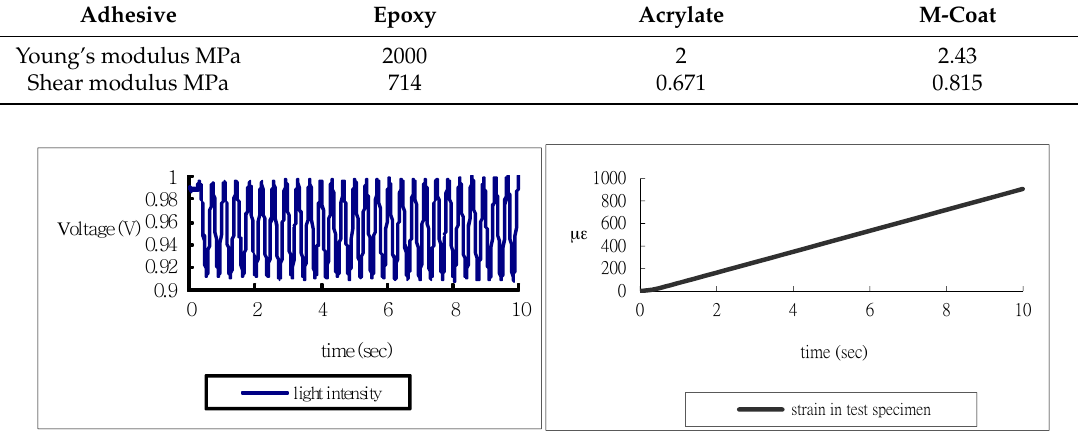
Figure 4. Light intensity of Mach-Zehnder interferometer and strain of test specimen measured by strain gauge for epoxy adhesive with bonding length 60 mm.